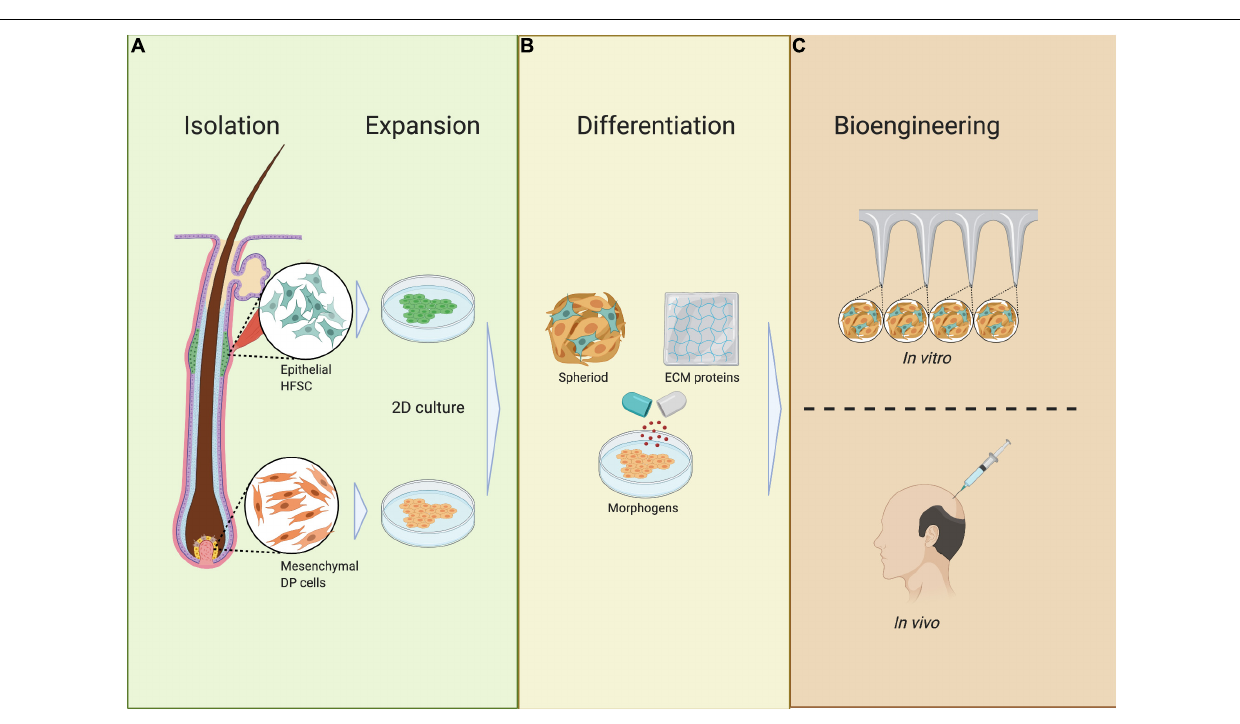
Frontiers in Cell and Developmental Biology |